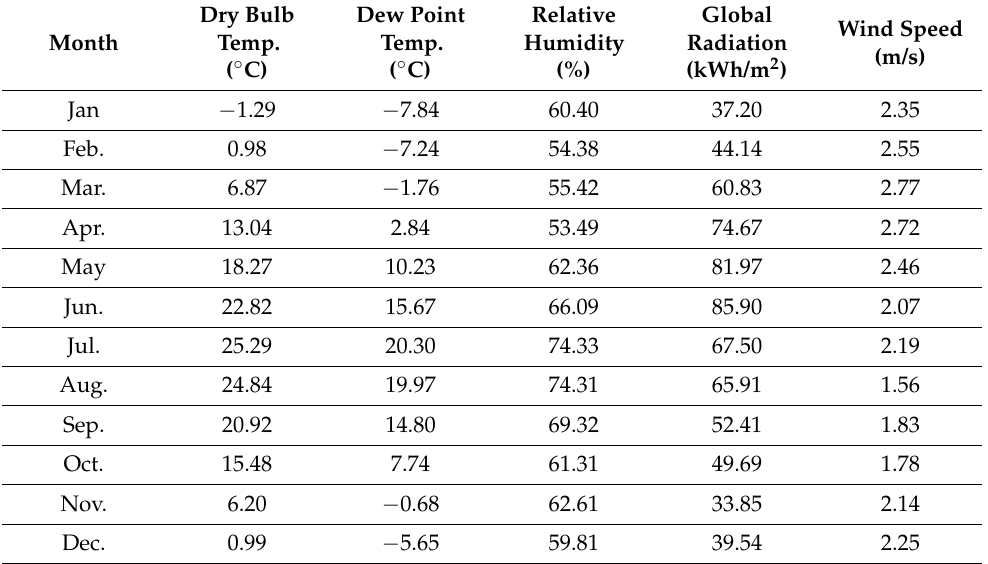
Table 4. Weather data factors and monthly